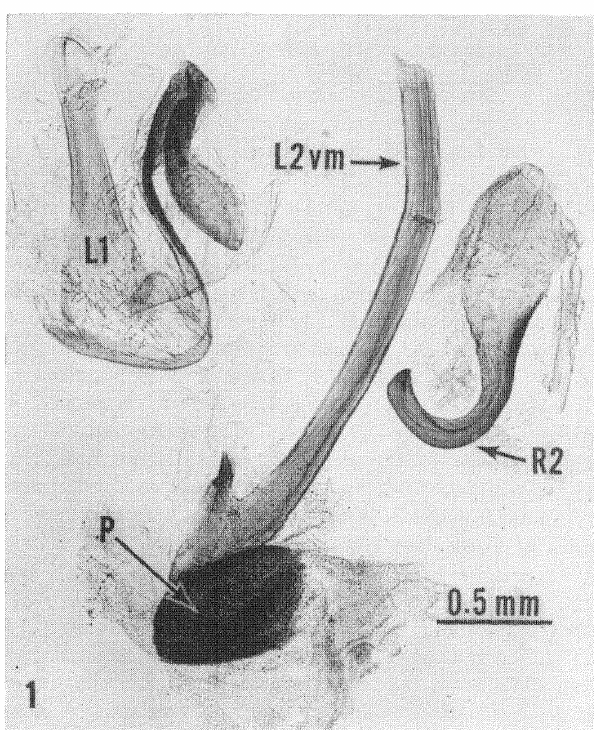
Figure 1. Calolamlra confusa. Male genitalia, dorsal view (115 MCZ), A. (without exact locality). L1 first sclerite of left phallomere; L2vm ventromedial sclerite of second sclerite of left phallomere; P prepuce; R2 hooked sclerite of right